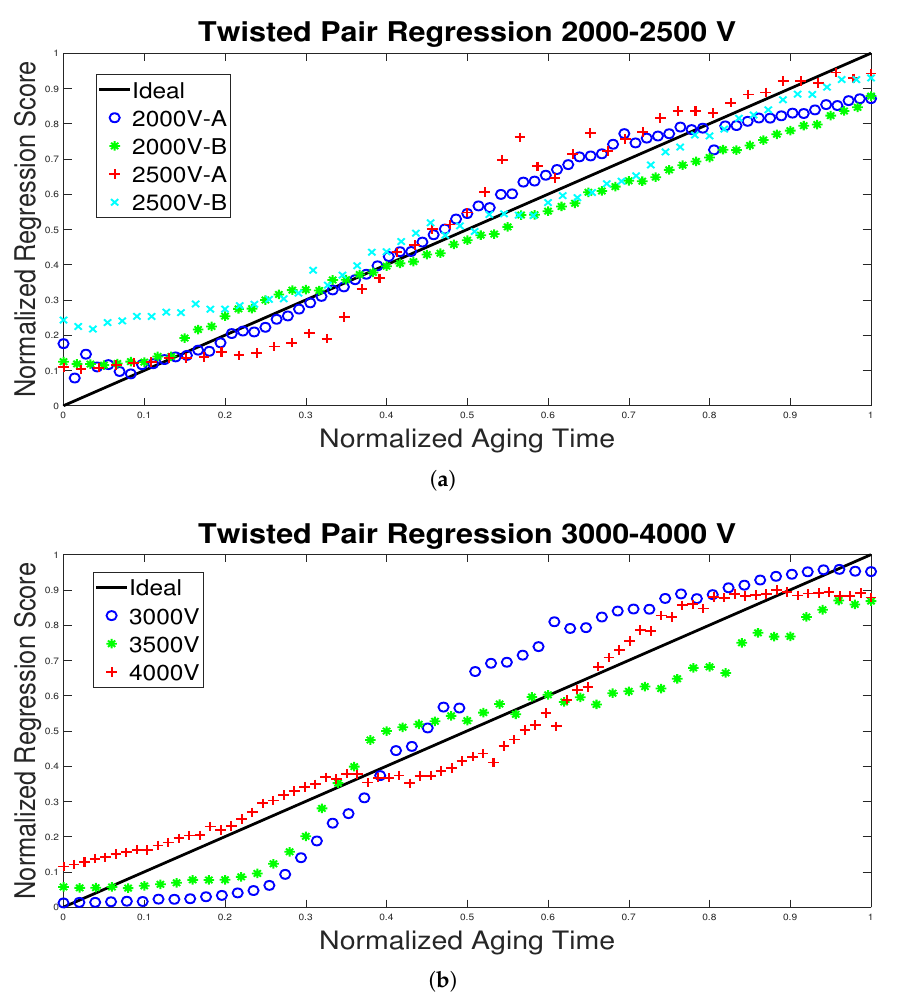
Figure 5. TPs aged with a power supply in the range [ 2000 2500 ] V ( a ) and in the range [ 3000 4000 ] V ( b